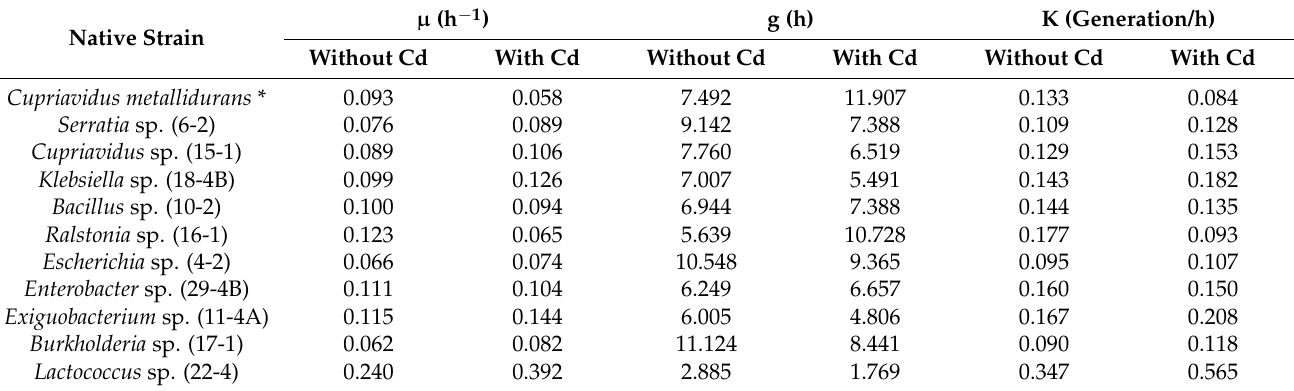
Table 2. Mean values of growth parameters with and without Cd in nutrient broth.